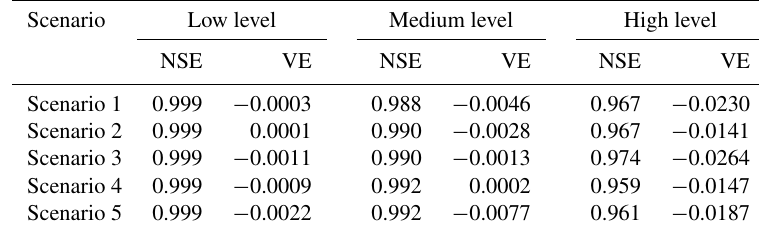
Table 5. Performance of runoff estimations for various parameter changes under different levels of uncertainty in the synthetic experiment.